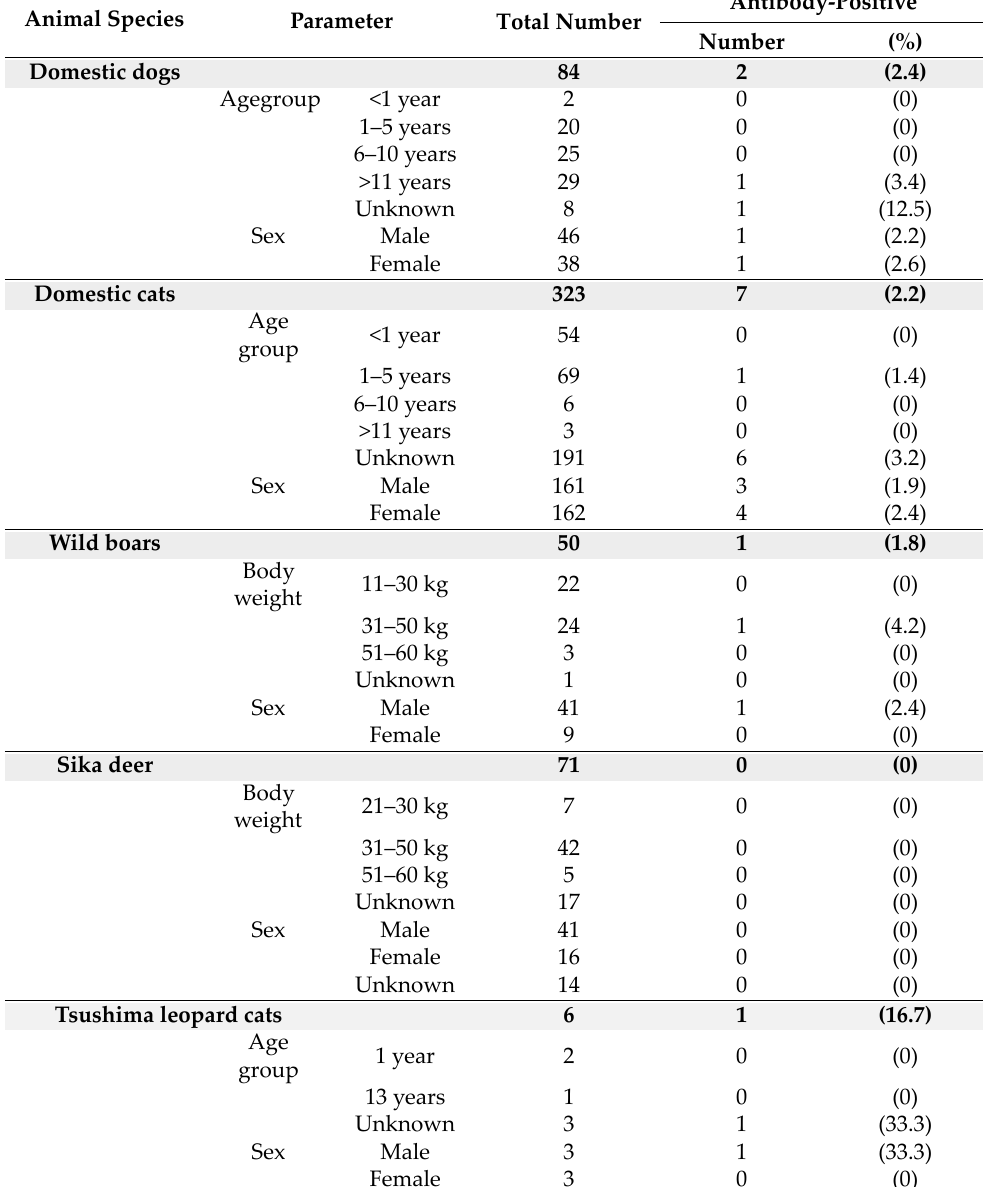
Table 1. Seroprevalence of SFTSV infection in animals on Tsushima Island.